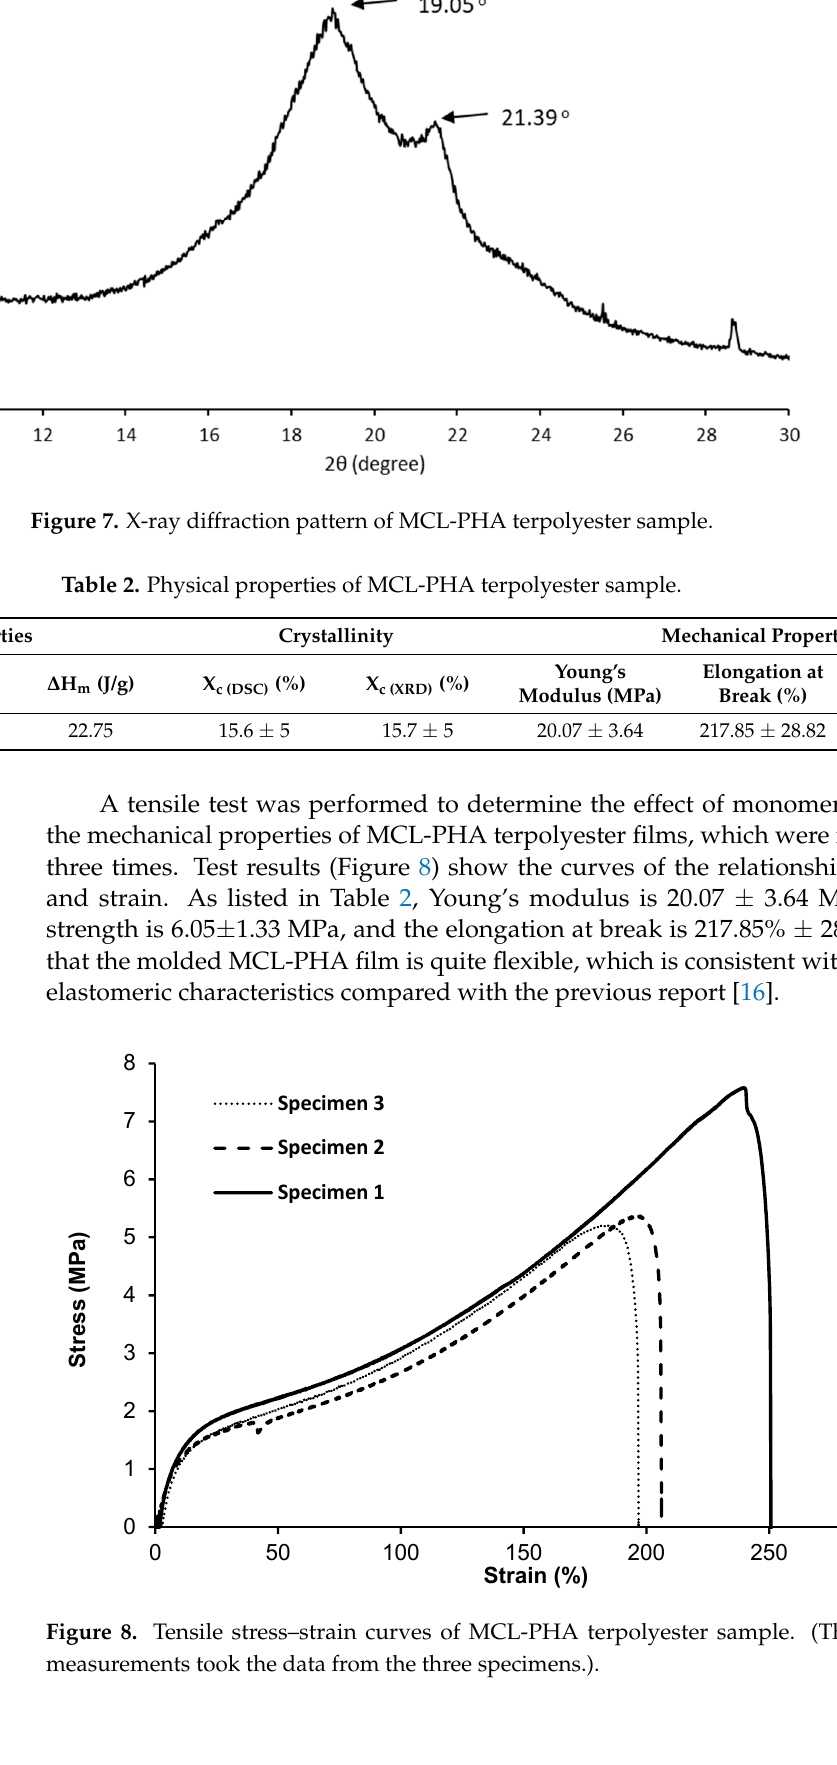
Figure 8. Tensile stress–strain curves of MCL-PHA terpolyester sample. (The repeated 3-time measurements took the data from the three specimens.) Table 2. Physical properties of MCL-PHA terpolyester sample.